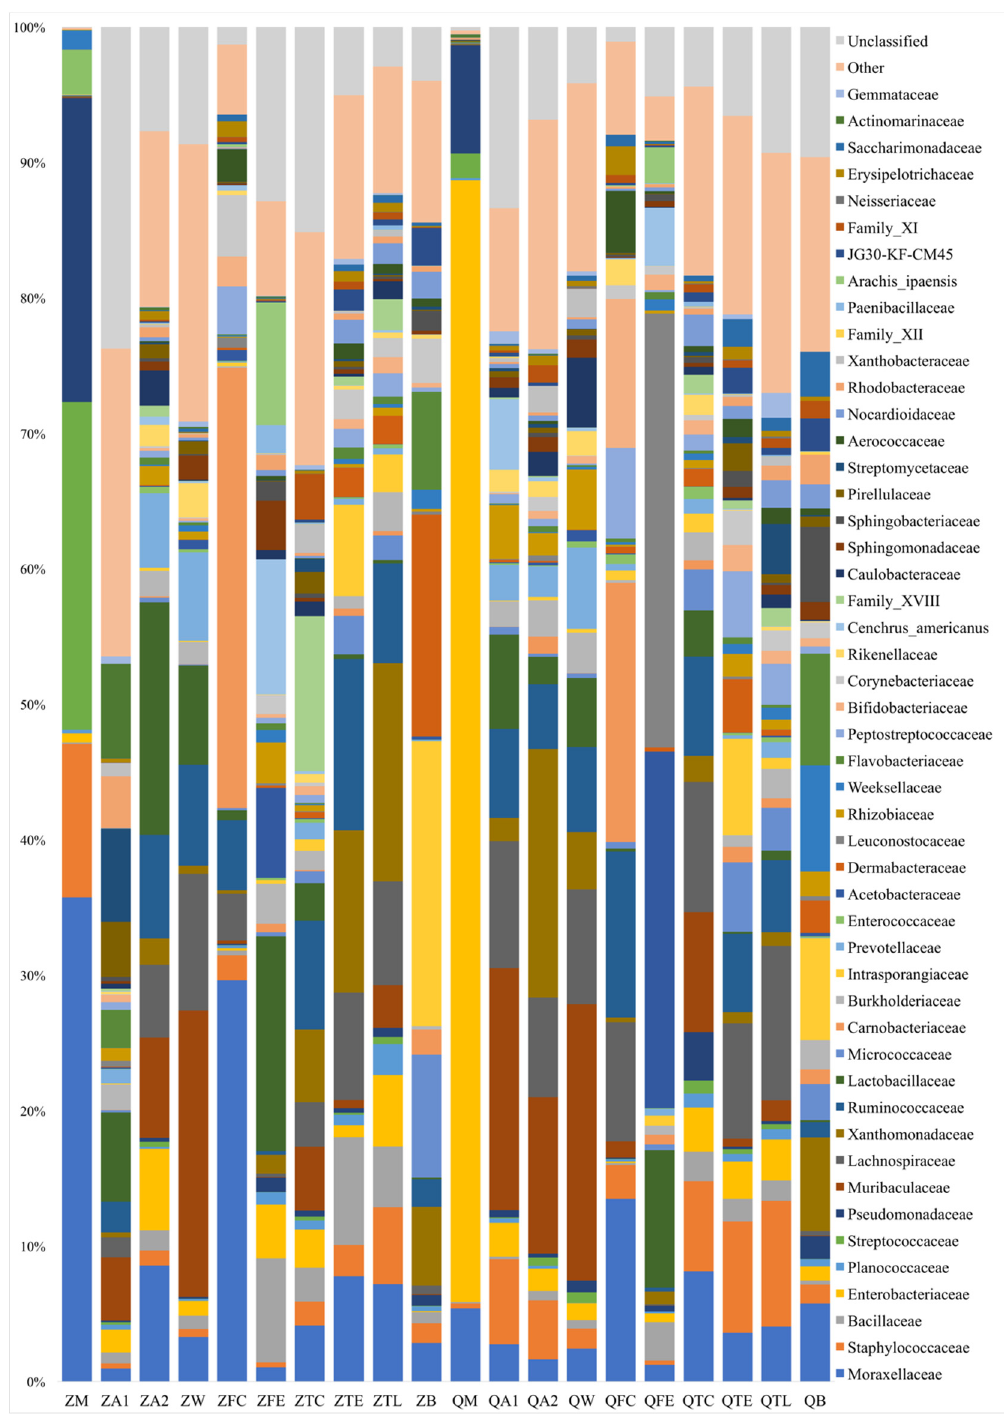
Figure 2. Relative abundance of bacterial families of milk and environmental samples .